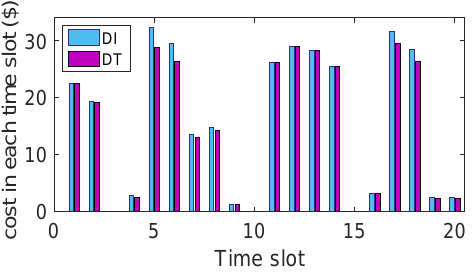
Figure 6. Cost of DT/DI(delay-tolerant/delay-intolerant) tasks in each time slot.